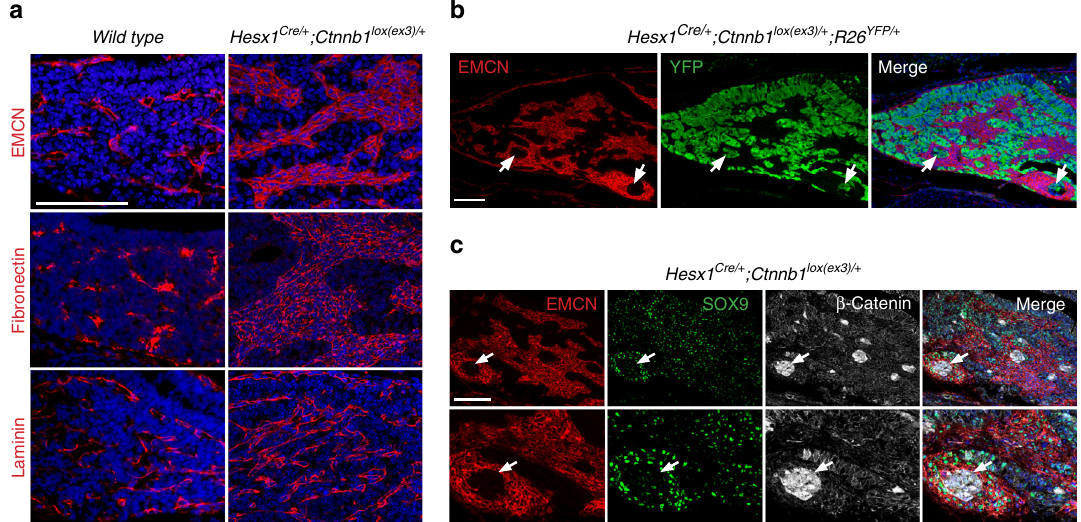
Fig. 4 Tissue microenvironment changes in the pre-tumoural pituitary of Hesx1 Cre/ + ; Ctnnb1 lox(ex3)/ + mutants. a Immunostaining against endomucin (EMCN), fi bronectin and laminin revealing changes in the parenchyma of the pre-tumoural pituitary at 18.5 dpc. Scale bar: 100 μ m. b Mutually exclusive staining of YFP+ (detected with an anti-GFP antibody) and EMCN+ cells. Note the presence of YFP+ cells (arrows) surrounding a population of EMCN+ cells. Scale bar: 100 μ m. c Triple immunostaining showing the co-expression of EMCN and SOX9 in large group of cells around the β -catenin-accumulating clusters (arrows). Results are representative of experiments conducted in six mice. Scale bar: 100 μ